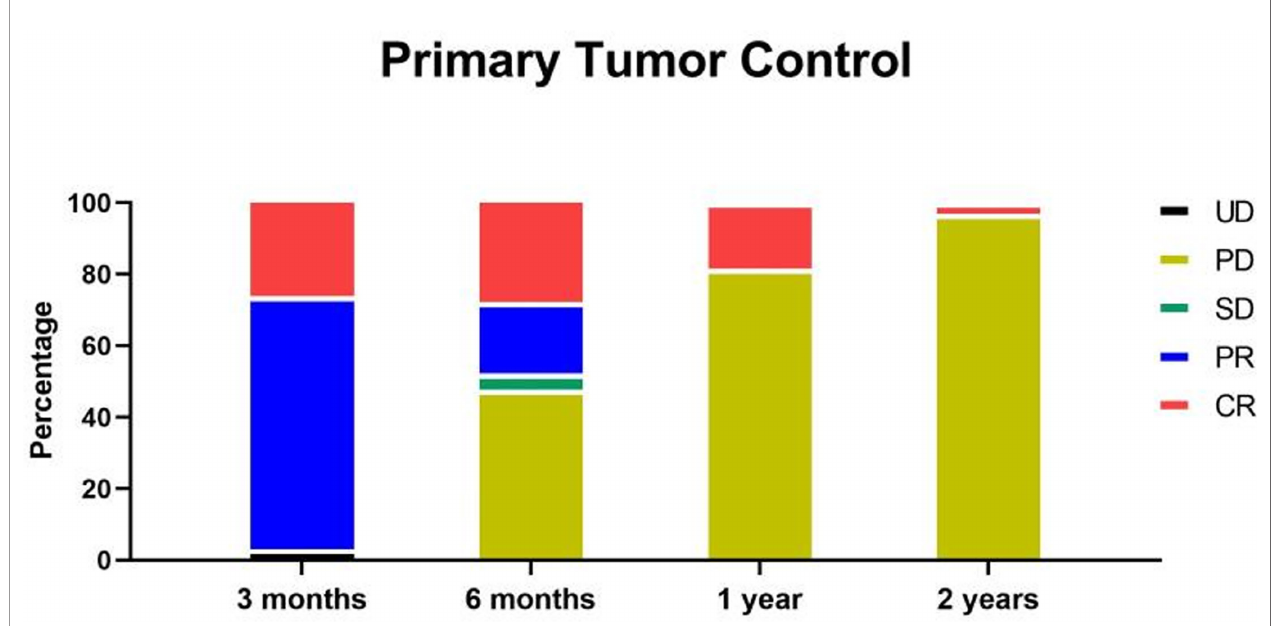
FIGURE 4 | At 3 months after radiotherapy, 18 patients (27.7%) reached CR, 45 patients (69.2%) reached PR, and two patients (3.1%) showed UD. At 6 months after radiotherapy, 18 patients (27.7%) were still CR, 13 patients (20.0%) were still PR, three patients (4.6%) were stable (SD), and 31 patients (47.7%) were progress (PD), including two patients with UD. At 1 year after radiotherapy, 12 patients (18.5%) were still CR, and the rest patients were all PD. At 2 years after radiotherapy, two patients (3.1%) were still CR, and the rest patients were all PD.